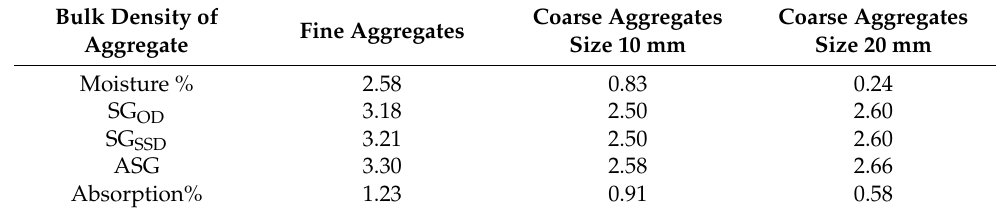
Table 2. Physical properties of fine and coarse